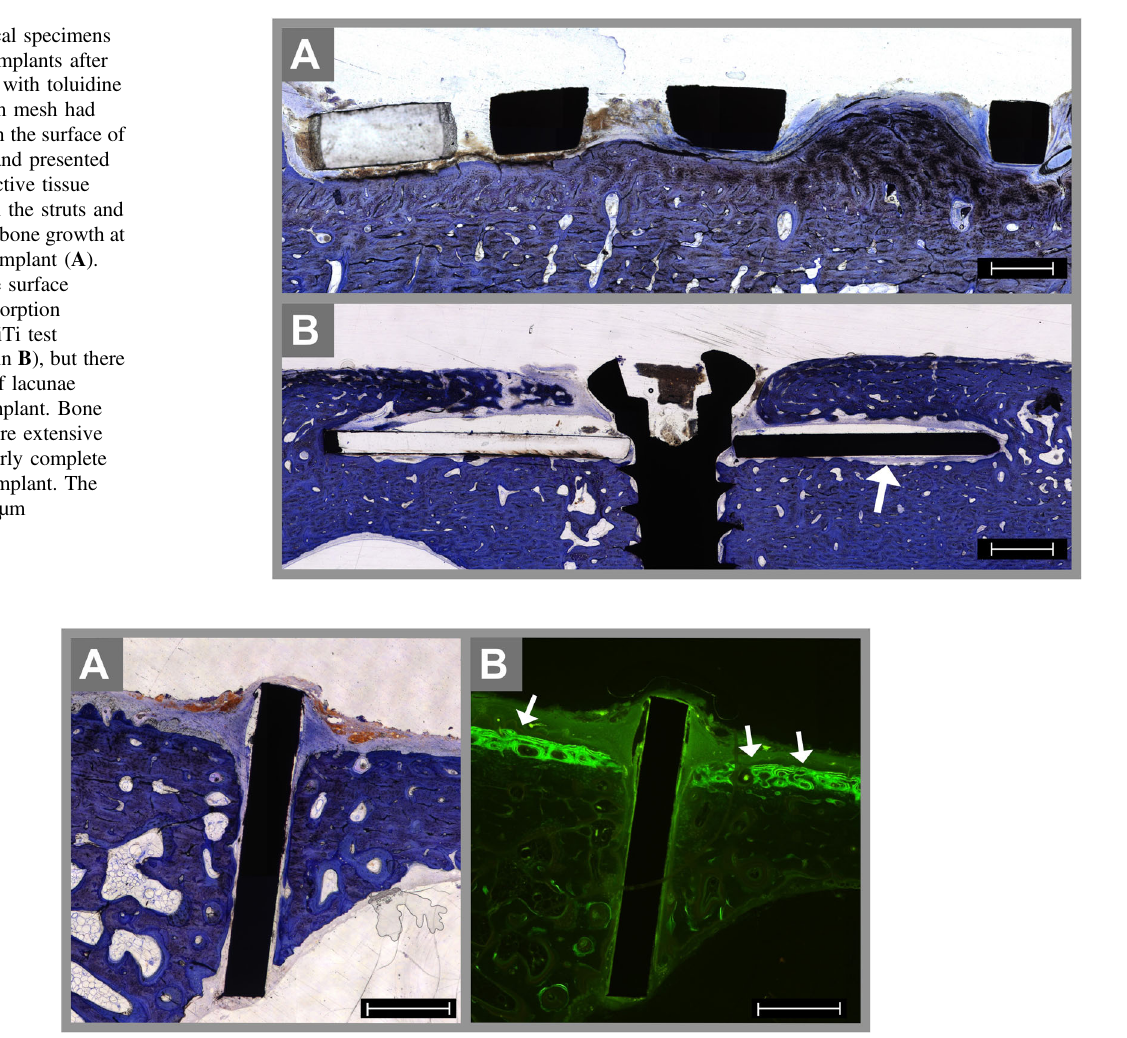
Fig. 4 Histological specimens of an intraosseous NiTi implant after 8 weeks stained with toluidine blue ( A ) and visualized by fl uorescence microscopy ( B ). The profound edge of the implant reaches the epi- thelium of the nasal cavity. The enrichment of green fl uorescence